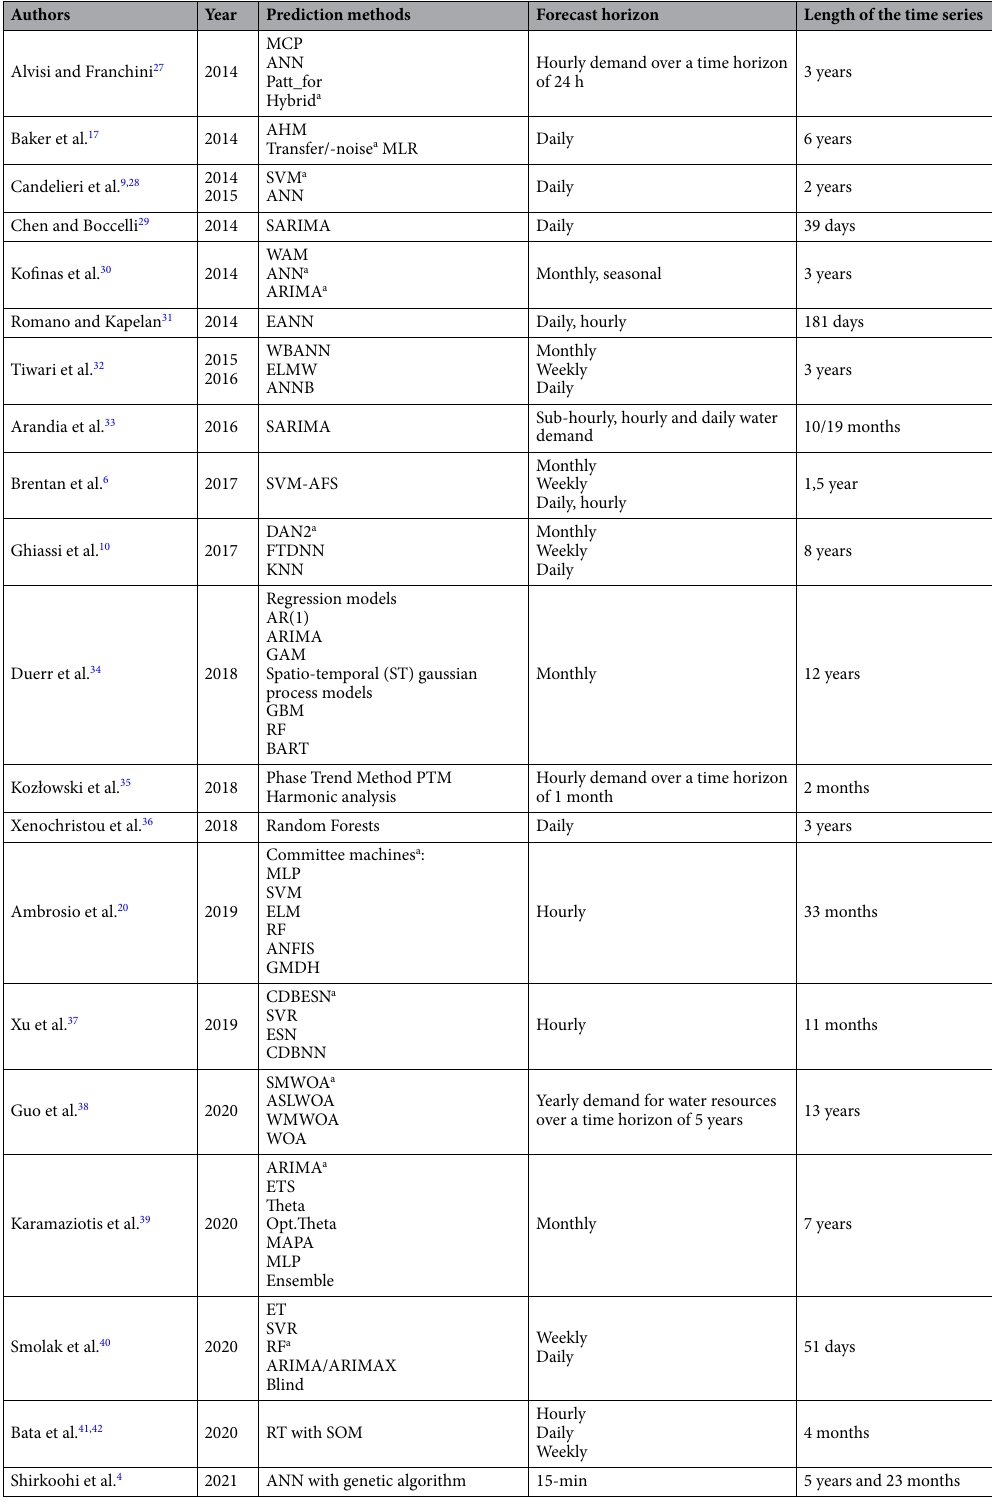
Table 1. Review of the water demand forecasting methodology. a The best matching effects when compared to the